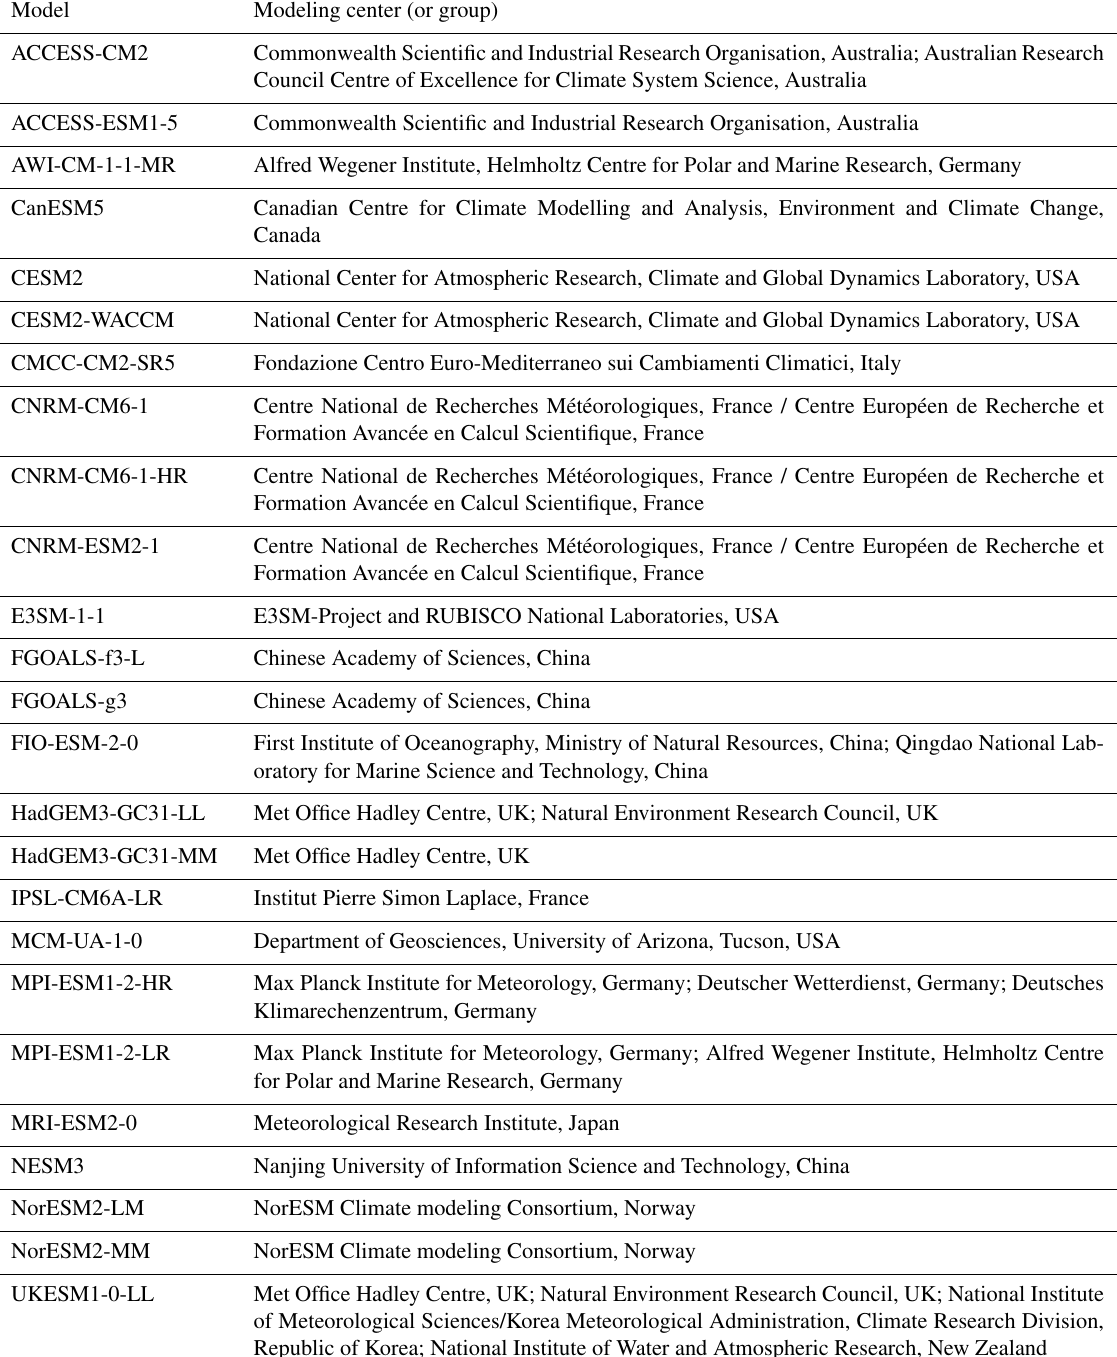
Table A1. List of the 25 employed CMIP6 models and the modeling groups providing them.